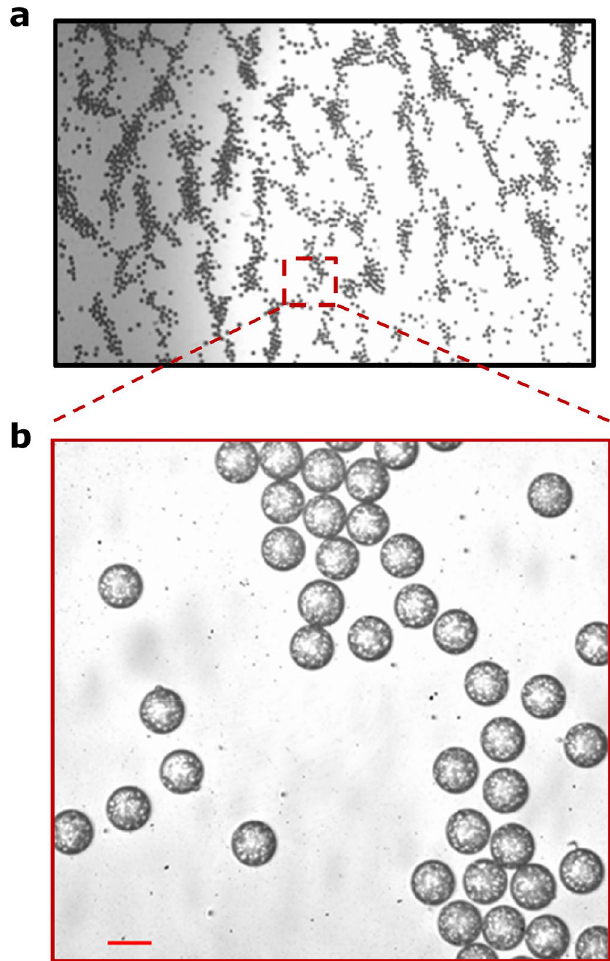
Figure 3. Magnification of 29 µm microparticles demonstrating the monodispersity (PDI = 1.6%) and morphology. ×4 magnification ( a ) and ×40 magnification ( b ) on an inverted microscope. Scale bar is 29 µm.